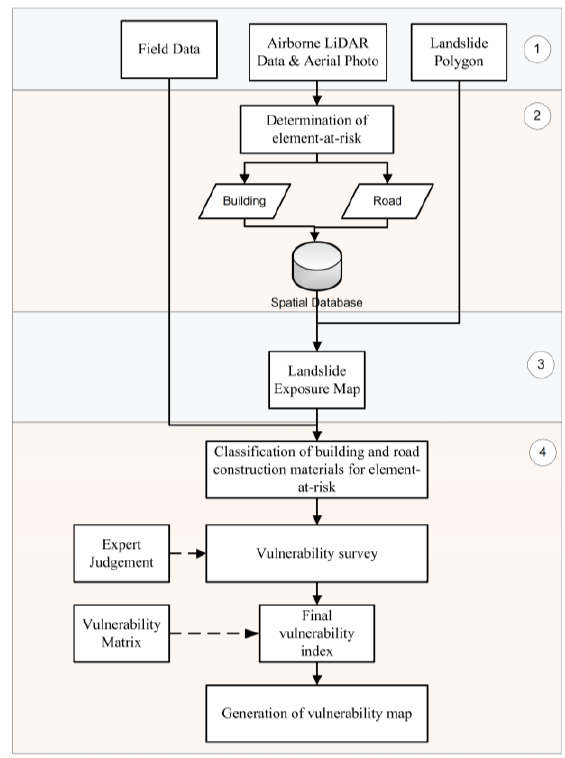
Figure 2. Overall methodology of the study